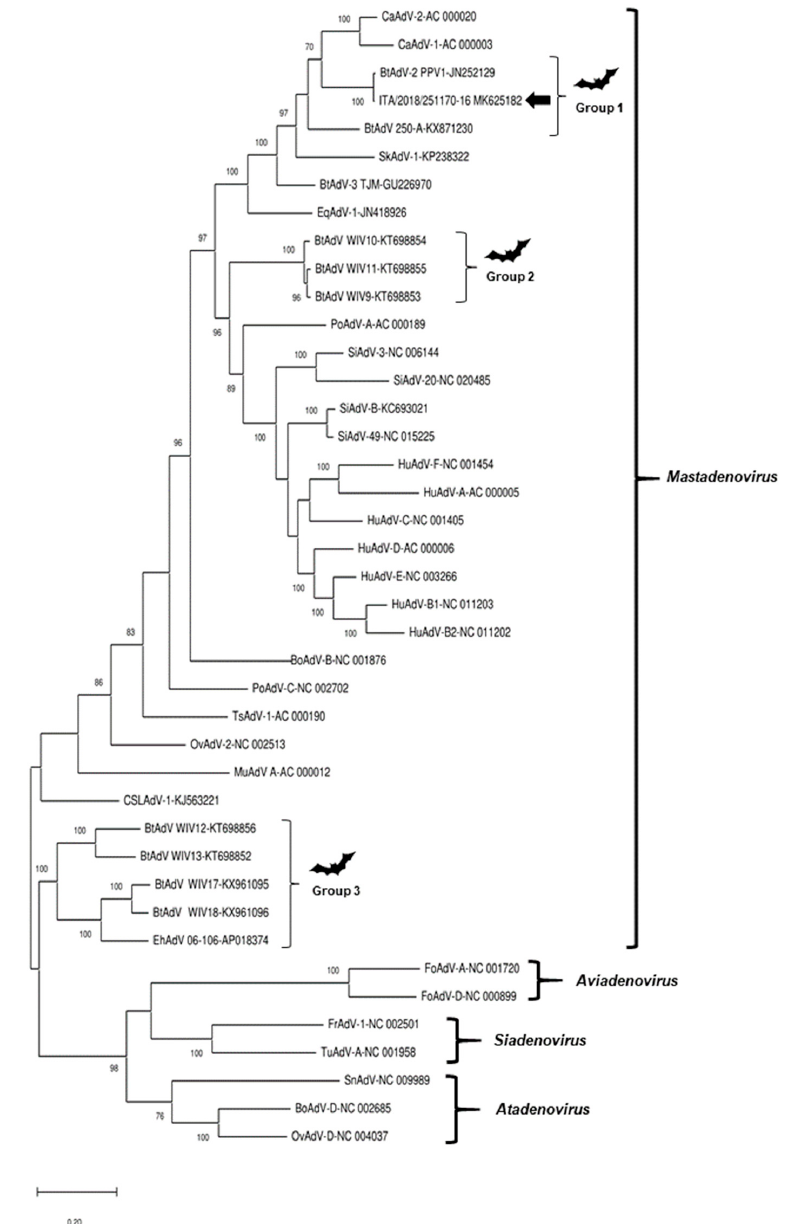
Figure 3. Phylogenetic tree based on the full-length genome of representative members of Mastadenovirus , Aviadenovirus , Siadenovirus , and Atadenovirus genera. GenBank accession numbers are provided for reference strains. The tree was generated using the maximum-likelihood method with the Jukes–Cantor algorithm of distance correction, with bootstrapping up to 1000 replicates. Bootstrap values >70% are shown. Scale bar indicates nt substitutions per site. Black arrow indicates the strain retrieved in this study. CaAdV, canine adenovirus, BtAdV, bat adenovirus, SkAdV, skunk